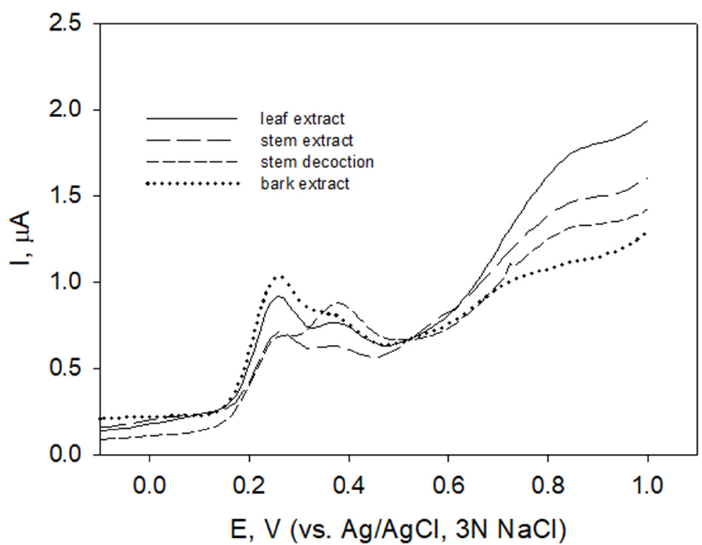
Figure 2. Differential pulse voltammograms of carbon paste electrode in R. idaeus leaf, stem, and bark extracts (diluted 1:5) prepared at room temperature and stem decoction in phosphate buffer pH 6.0; potential step 4 mV, pulse width 50 ms, pulse period 200 ms, pulse amplitude 50 mV.